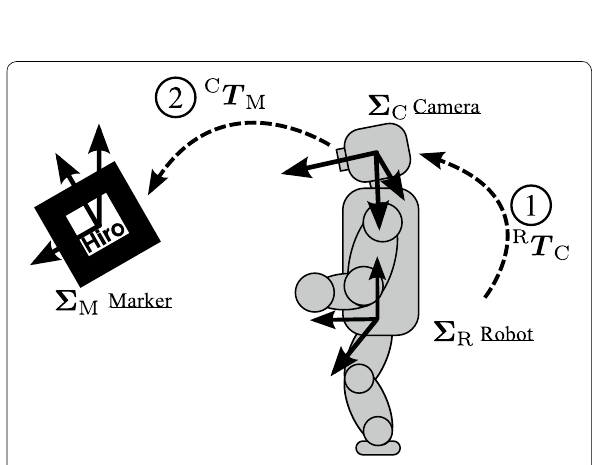
Fig. 8 The relationships between each coordinate